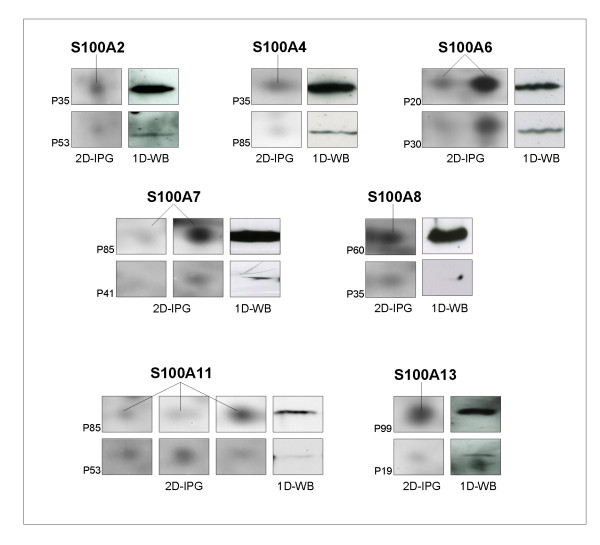
Western Blot validation of S100 proteins detected by silver stain proteomics. The panel shows the cropped areas of 2 D gels containing the silver stained S100 protein spots (left), paired with the 1D-western blot image on the same selected breast cancer tissue (right). The validation was performed on two surgical samples for each S100-antibody, chosen among the 100 patient tissues showing respectively high and low levels of each S100 protein.